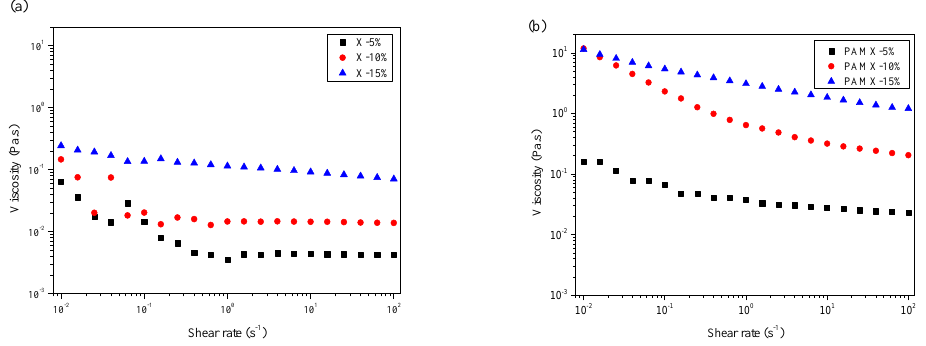
Figure 5. Shear rate dependence of viscosity for xylan (X) ( a ); and xylan-g-PAM (PAMX) ( b ) at different concentrations.